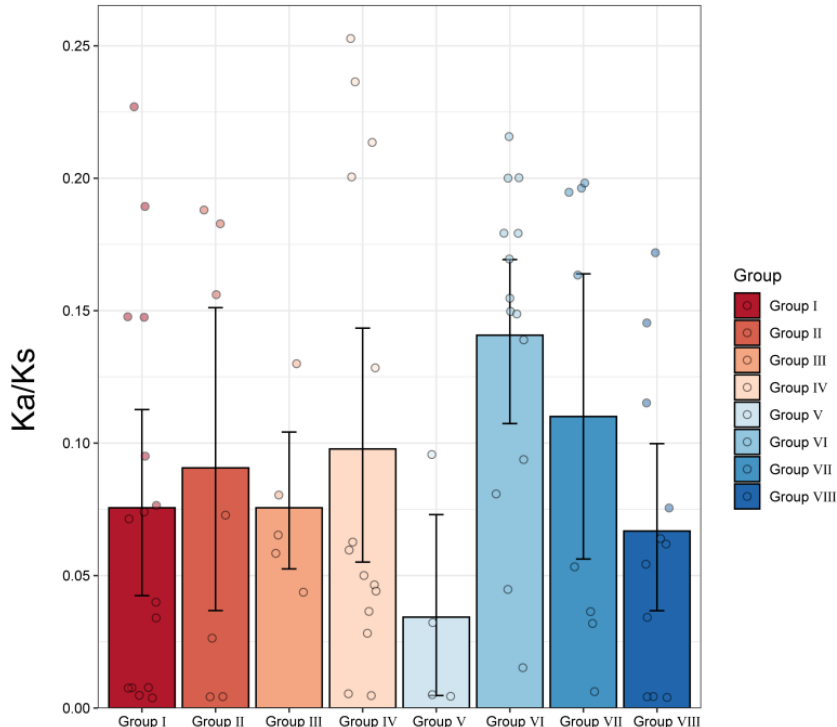
Figure 4. Bar plot of average Ka/Ks ratios for homologous CML gene pairs between rice and P. vaginatum . The different colors indicate eight subfamily groups identified in phylogenetic analysis. The error bar is shown in the figure.